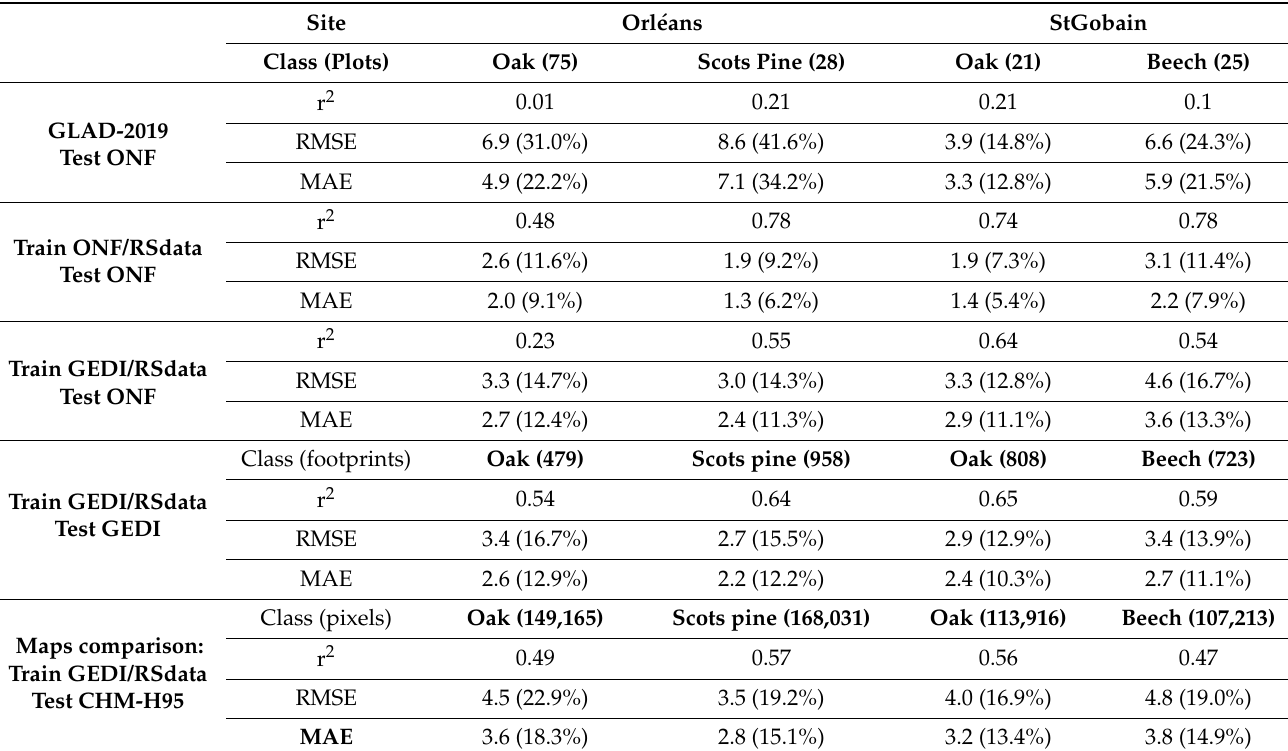
Table 2. Validation statistics of the estimation of dominant height (Hdom) of the four classes. Training and test/validation data are indicated in the left column, RSdata: satellite image features from Sentinel-1, Sentinel-2 and ALOS-2 PALSAR-2. Site Orl é ans StGobain Class (Plots) Oak (75) Scots Pine (28) Oak (21) Beech